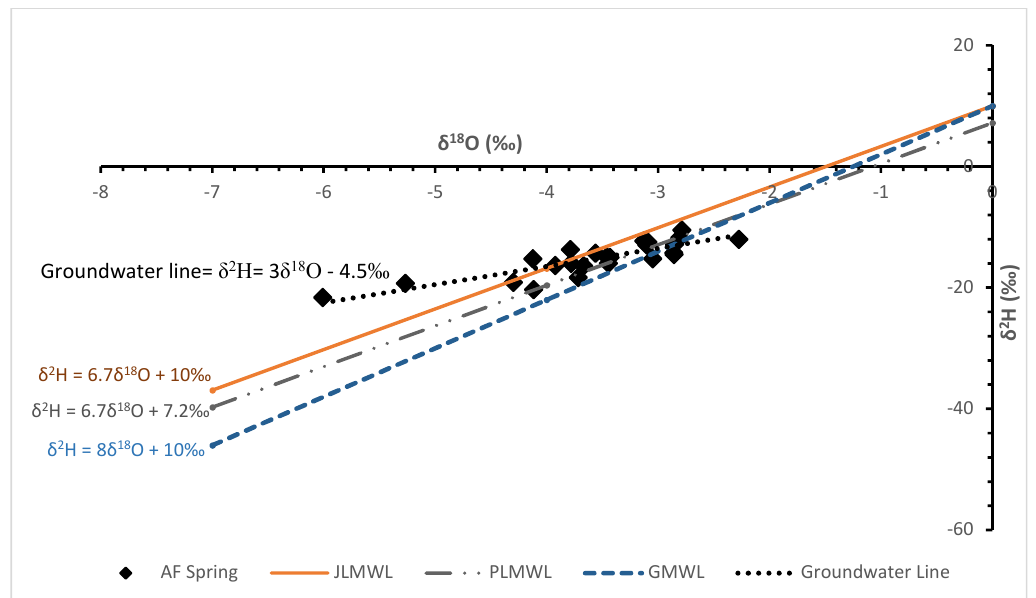
Figure 4. Stable isotopes of Albert Farm spring in comparison to the Johannesburg Local Meteoric Water Line, Pretoria (LMWL (δ 2 H = 6.7δ 18 O + 7.2‰ GNIP-IAEA) and Global MWL (δ 2 H = 8δ 18 O + 10‰) [39].